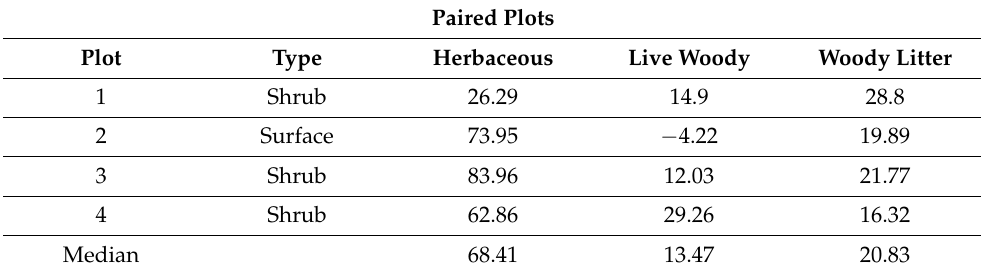
Figure 3. Predicted vs. actual plots for live woody material ( A ), herbaceous fuel ( B ), and woody litter ( C ). Lines represent linear regression with R 2 values of 0.37, 0.75, and 0.79 for A, B, and C respectively. Table 3. Fuel consumption (g) in four plots for each fuel category. Before treatment application, pre-fire and post-fire plots were paired based on dominant fuel type. Fuel consumption in paired plots was calculated by subtracting biomass in post-fire plots from biomass in pre-fire plots within fuel categories. The regression equation for each fuel type was used to estimate biomass present in post-fire plots before the burn from voxel/volume data. Fuel consumption was then calculated by subtracting collected biomass in post-fire plots from estimated biomass in post-fire plots before the